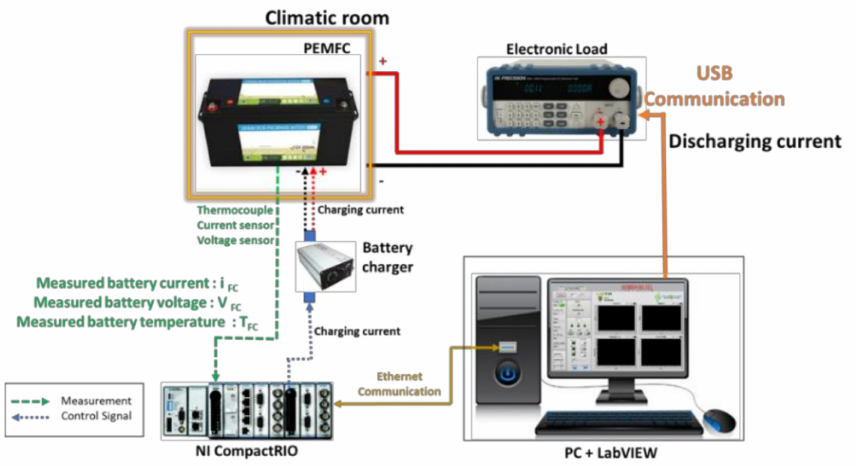
Figure 7. Battery test